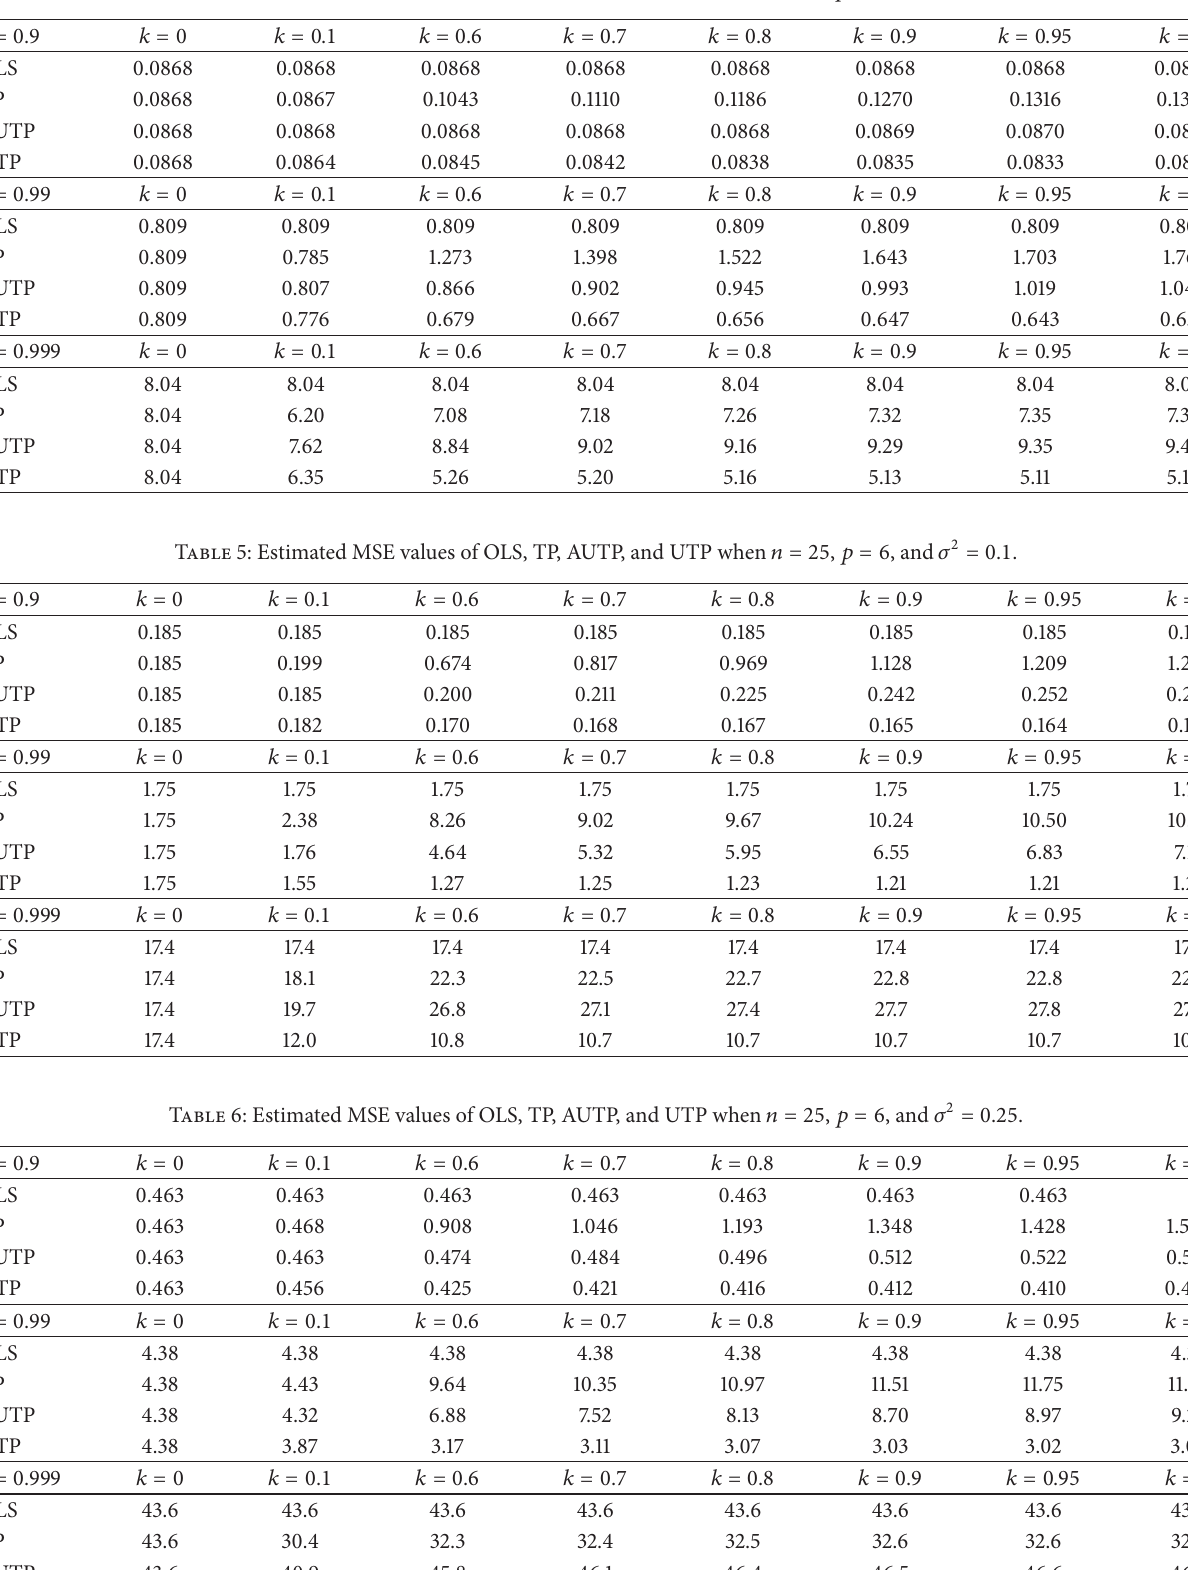
Table 4: Estimated MSE values of OLS, TP, AUTP, and UTP when 𝑛 = 50 , 𝑝 = 4 , and 𝜎 2 = 0.25 .